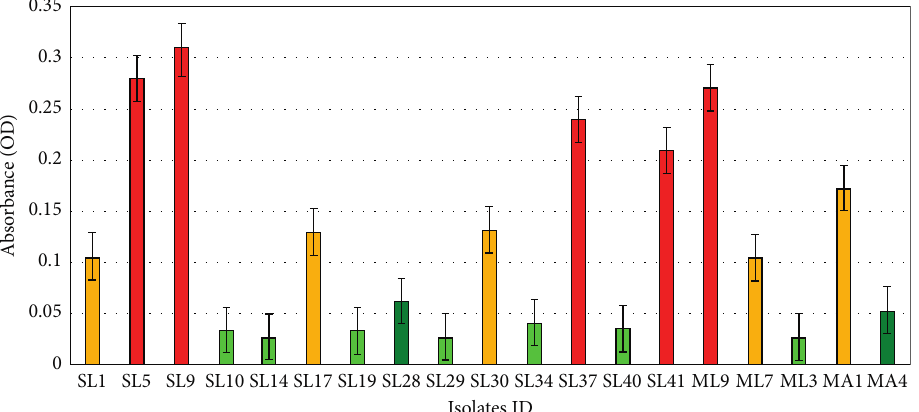
Figure 2: Results of biofilm formation in the microtiter plate assay by individual isolates. Red, yellow, light green, and bottle green indicated the strong, the moderate, the weak, and the lack of biofilm formation ability, respectively. Y-axis represents the numerical values of the absorbance of each isolate, and X-axis represents the isolates. Here, the absorbance values represent the average OD of each isolate. The S. lentus strains: SL1, SL5, SL9, SL10, SL14, SL17, SL19, SL28, SL29, SL30, SL34, SL37, SL40, and SL41; the M. luteus strains: ML9, ML7, and ML3; and M. aloeverae strains: MA1,and MA4 showed OD of 0.106, 0.28, 0.31, 0.034, 0.0273, 0.13, 0.033, 0.062, 0.027, 0.132, 0.041, 0.24, 0.035, 0.21, 0.273, 0.104, 0.028, 0.173, and 0.053, respectively.